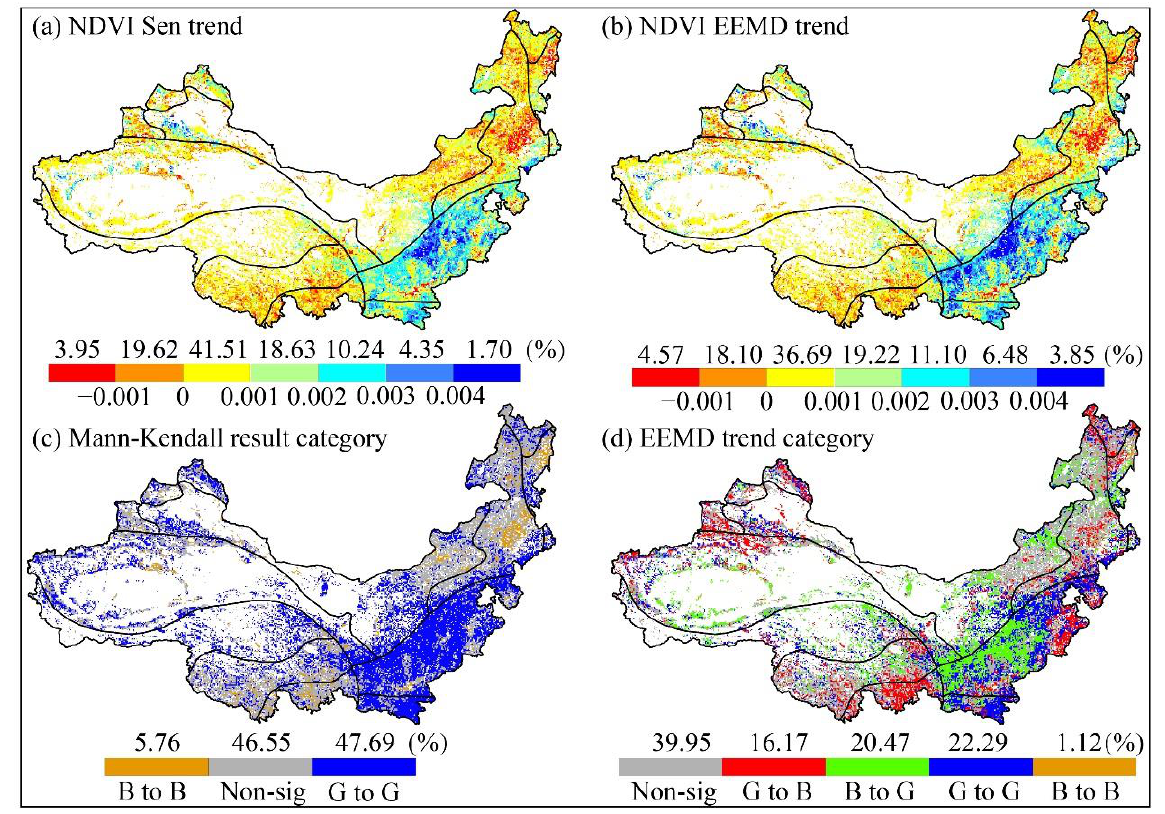
Figure 5. Spatial distribution of NDVI liner trend ( a ) and its significance ( c ), the average EEMD trend ( b ) and its significance ( d ) in growing season (Non-sig: Non-significant, G to B: Greening to browning, B to G: Browning to greening, G to G: Monotonic greening, B to B: Monotonic browning).